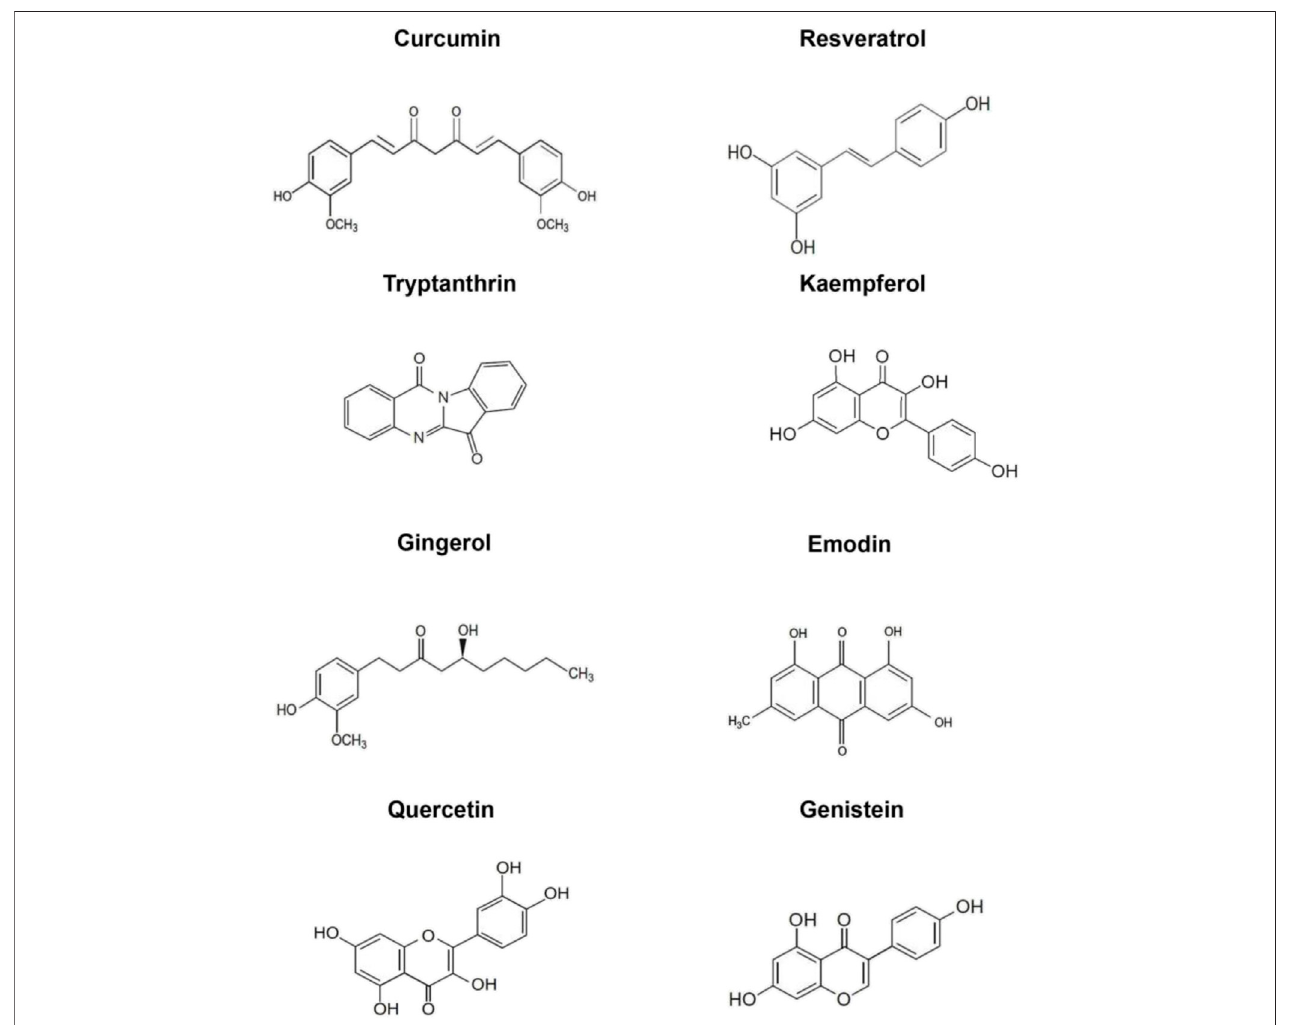
FIGURE 3 | Chemical structures of the phytochemicals analysed as chemopreventives in the current study. i) Curcumin ii) Resveratrol (Nair et al., 2021) iii) Tryptanthrin (Shankar et al., 2015) iv) Kaempferol (Silva dos Santos et al., 2021) v) Gingerol vi) Emodin vii) Quercetin viii) Genistein (Nair et al., 2021).